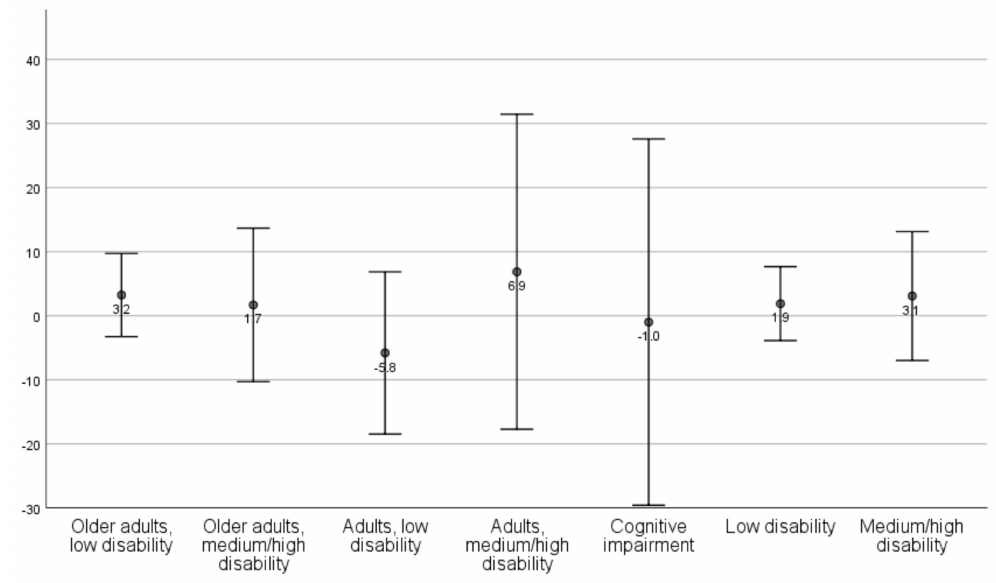
Figure 4. Mean changes (dots) with standard deviation (lines) in self-rated health, per client profile and aggregated client profiles. Values > 0 indicates improvement (i.e., increased self-rated health) from T1 to